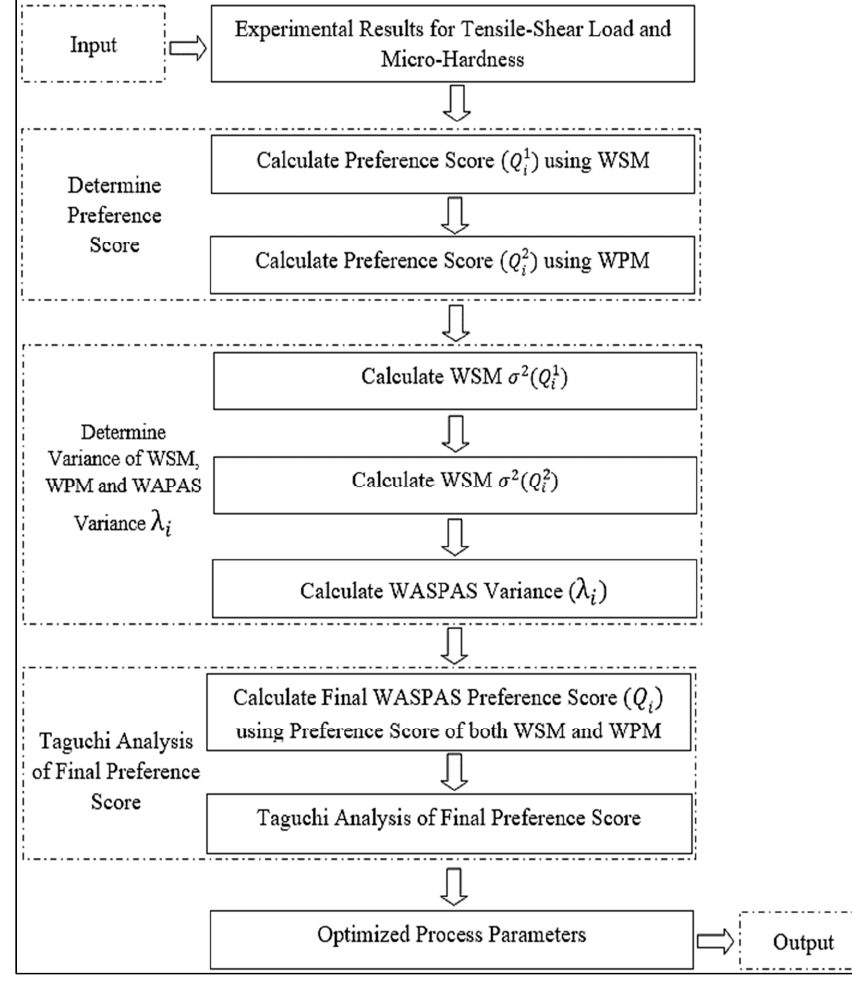
Figure 11. Flowchart of the hybrid WASPAS–Taguchi technique. Table 4. Performance matrix for WSM and